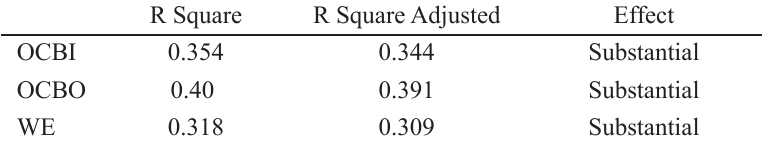
Variance Explained R Square R Square